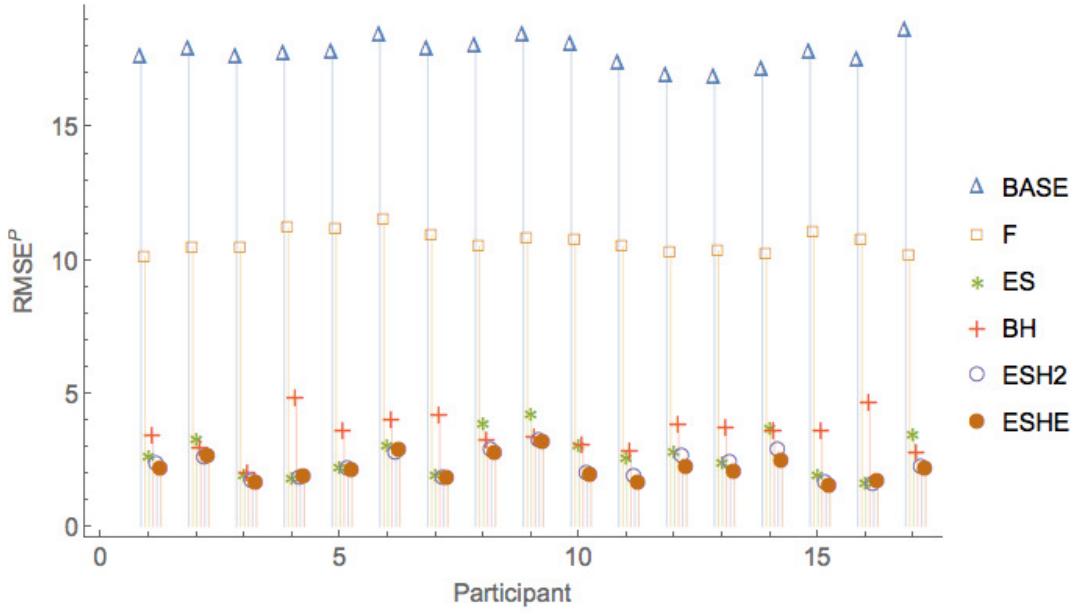
Figure 6. Comparison of leave-one-period-out LOOCV RMSE of all models for Session 2.